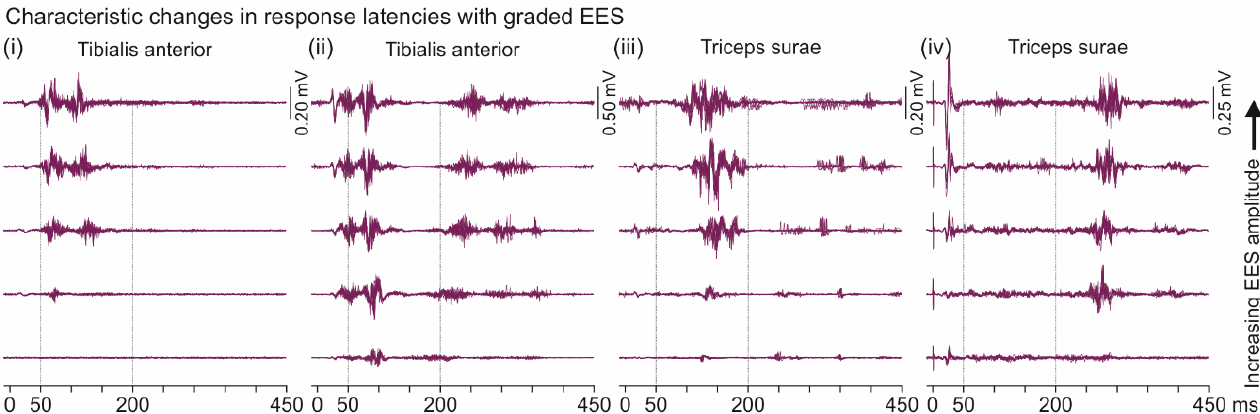
Figure 10. Increasing EES amplitude alters the onset of long-latency responses in TA and TS. Long-latency responses of TA ( i , ii ) and TS ( iii , iv ), ten stimulus-triggered traces superimposed each. Onset latencies of responses within 50–200 ms decreased, while those of responses within 200–450 ms increased with graded EES. ( i ) subject 1, recording 1, setup 0 − 2+; ( ii ) subject 8, recording 4, 0 − 3+; ( iii ) subject 3, recording 3, 1 − 3+; ( iv ) subject 8, recording 2, 3 − c+; increasing EES amplitudes from bottom to top, ( i – iii ) 6–10 V, and ( iv ), 4–8 V. EES, epidural electrical stimulation.